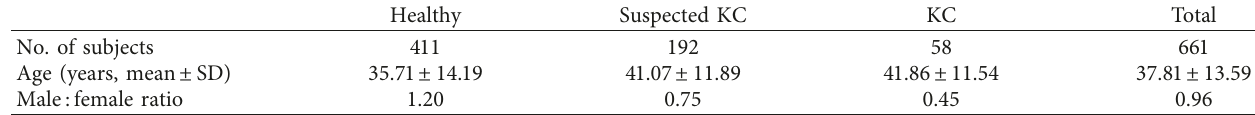
Table 1: General characteristics of the healthy, suspected KC, and KC groups.